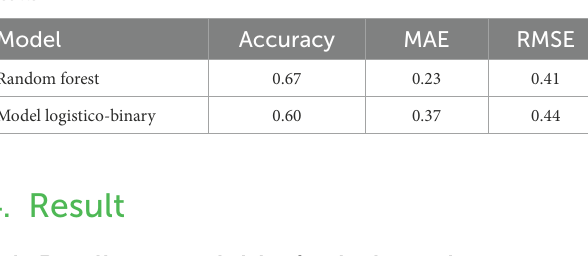
TABLE 3 Comparison of random forest versus binary logistic regression